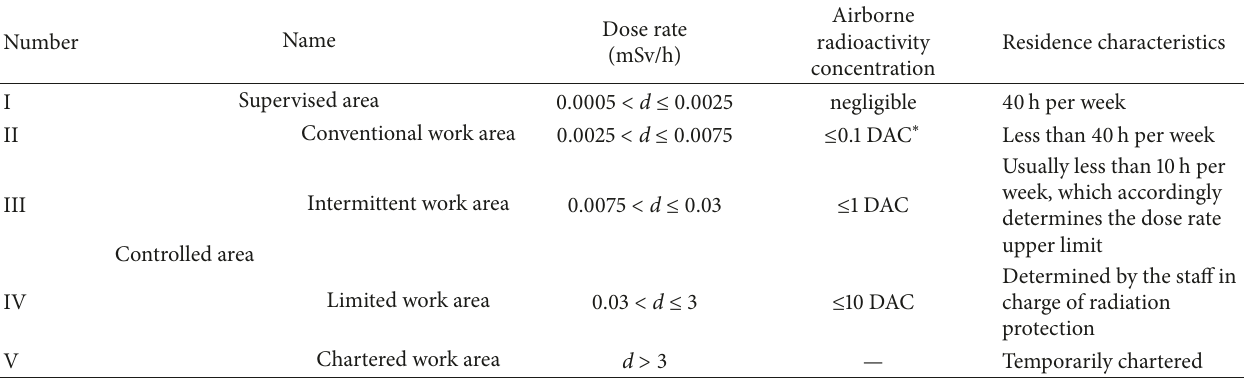
Table 1: Classification of radiation zones for the HTR-PM’s operation.